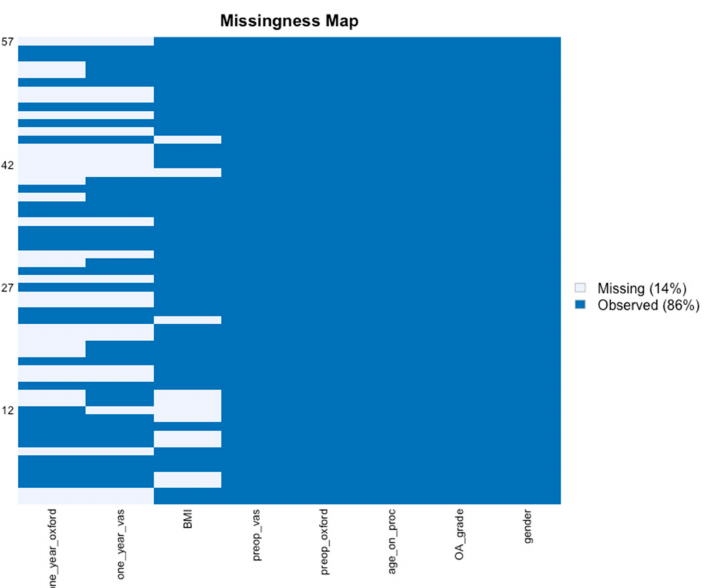
Figure 1. Missingness map MFAT data. Our dataset consisted of 57 sets of observations and 8 variables per set of observation, for a total of 456 data points. Missingness rate of 14% (light blue) due to patient lost-to-follow-up and 86% observed (blue). x -axis: outcome variables: Gender, Kellgren-Lawrence Osteoarthritis grade (OA Grade), age at the time of the procedure, Body Mass Index (BMI), Oxford Hip Score (OHS) for function, and Visual Analogue Scale (VAS) for pain at pre-operative baseline and one-year follow-up. y -axis: data points missing (14%) due to patients lost-to-follow-up. Source: authors’ data and reproducible statistical analysis with Open Access statistical software R (version 4.0.0 or higher).